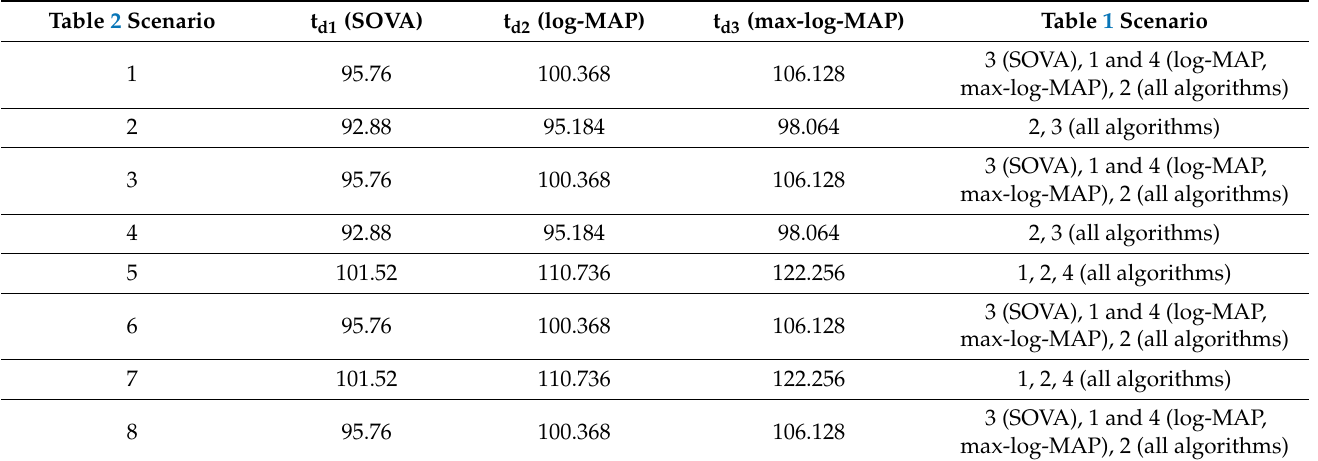
Table 4. Worst case end-to-end latency (ms) and corresponding Table 1 implementation scenario for each algorithm and scenario of Table 2.